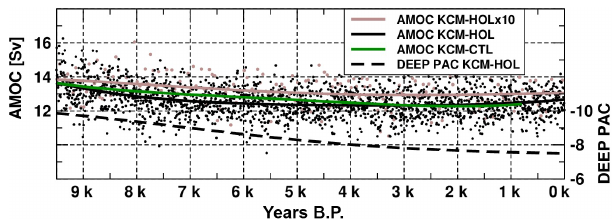
Figure 3. As in Fig. 2a but for the maximum meridional overturning circulation in the Atlantic at 30 ◦ N (solid lines, left axis) and for the deep Pacific between 3000m and 5000m depth at 0 ◦ N (dashed line, right axis) in Sv (10 6 m 3 s − 1 ).